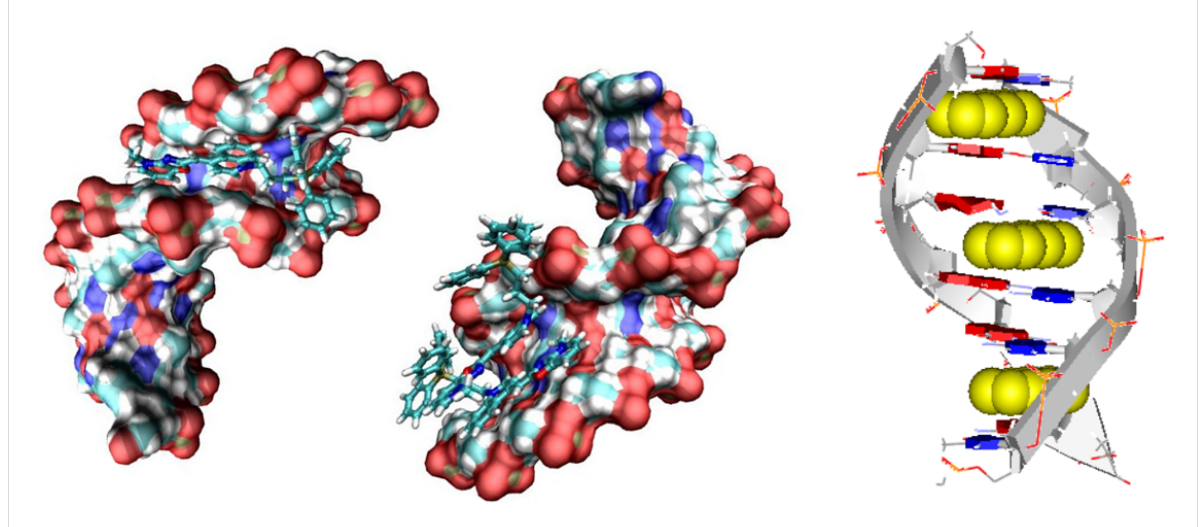
Figure 2: Schematic representation of ligand binding modes to DNA or RNA (left to right: DNA minor groove binding, minor groove aggregation, inter- calation), which can be distinguished by polarization spectroscopy methods.